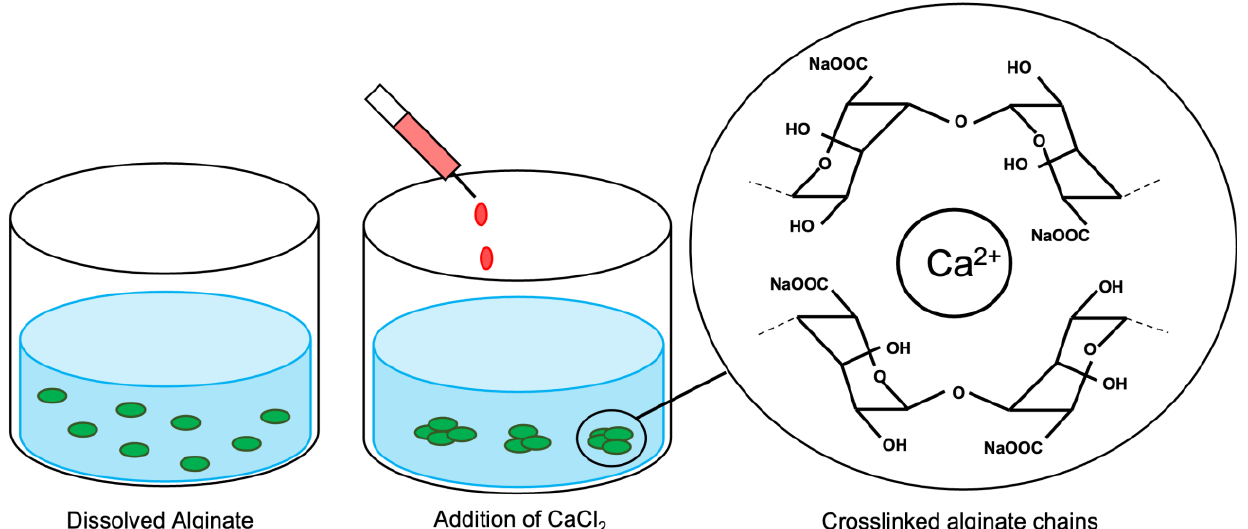
Figure 3. Schematic of AlgNPs synthesis using the ionic gelation method.